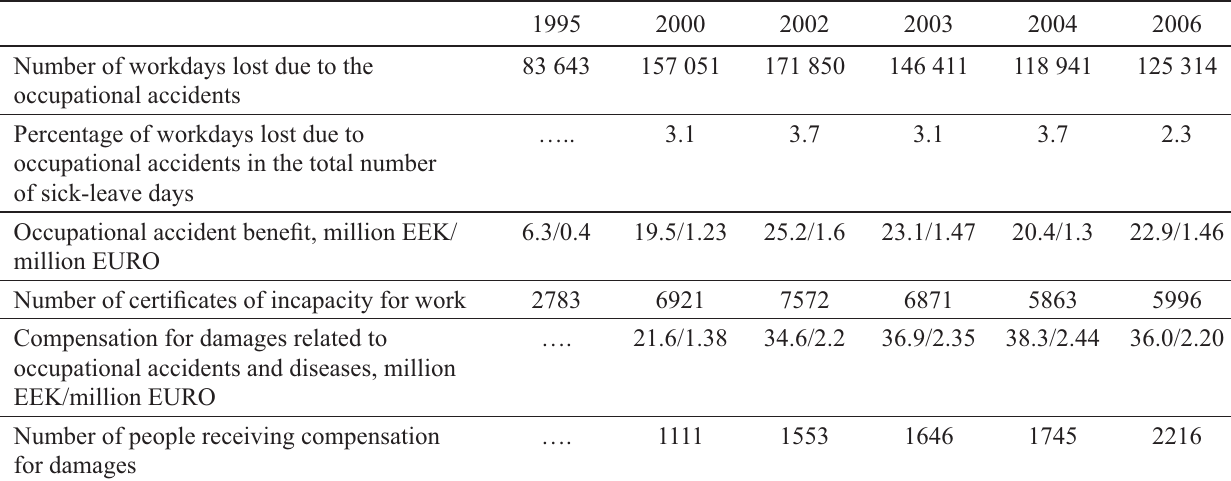
Table 1 . Number of workdays lost and expenses incurred due to occupational accidents (Ministry …